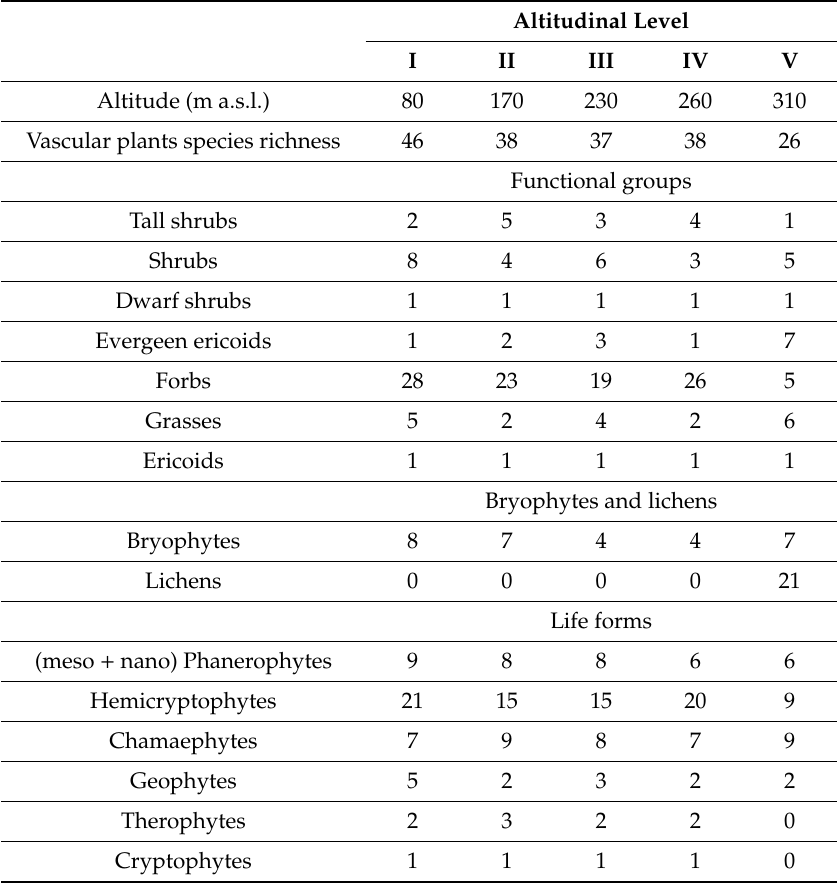
Table 1. Number of vascular plant species detected at the di ff erent altitudinal levels of the Slantsevaya mountain. Data are presented as richness of plant functional groups, bryophyte and lichen richness and plant life forms. Altitudinal Level I II III IV V Altitude (m a.s.l.) 80 170 230 260 310 Vascular plants species richness 46 38 37 38 26 Functional groups Tall shrubs 2